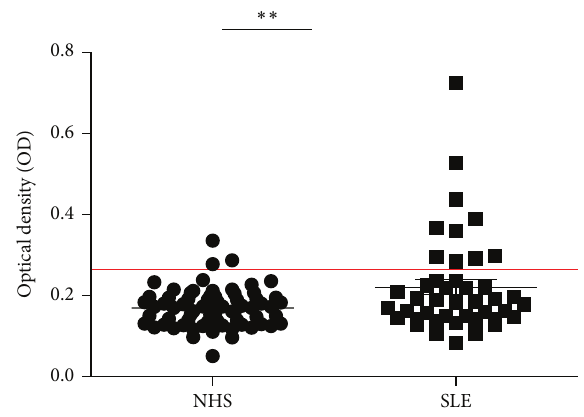
Figure 1: Titer of autoantibody against MDM2 in human sera by ELISA. The range of antibody titers to MDM2 was expressed as optical density (OD) obtained from ELISA. The mean + 2SD of NHS was shown in relationship to all serum samples. Titer of anti-MDM2 in SLE serum was much higher than that in NHS ( 𝑃 < 0.01 ). The cutoff value line for positive samples is indicated in the figure.